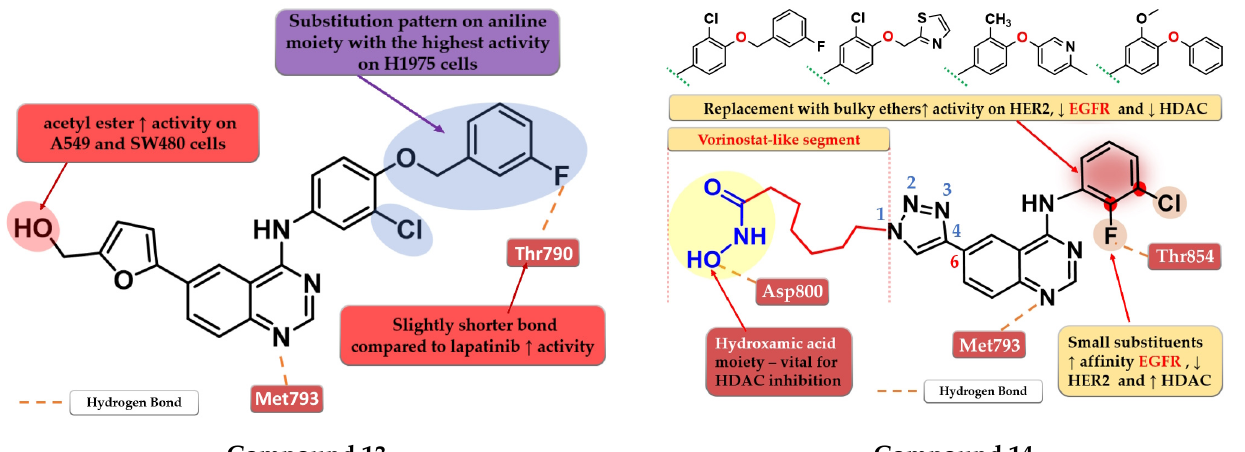
Figure 9. Structure–activity relationship and molecular docking of compound 13 in the human EGFR kinase domain (PDB ID 1XKK) [101], as reported by Zhang et al. [118]; structure–activity relationship and molecular docking of compound 14 in the human EGFR kinase domain (PDB ID 1XKK) [101], as reported by Ding et al. [119].